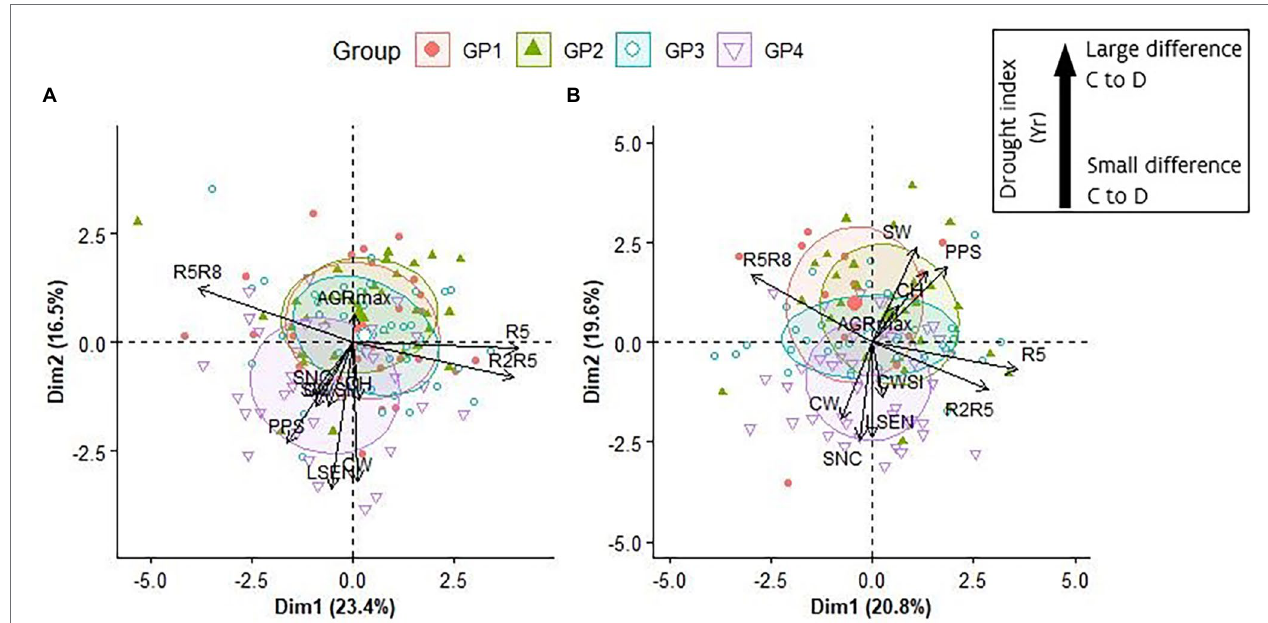
FIGURE 6 | Representation of the first two axes of a Principal Component Analyses (PCA) performed on Yr data of R5, R2R5, R5R8, PPS, SW, AGRmax, CH, SNC and CWSI and BLUP values for LSEN and CW in 2018 (A) and in 2019 (B) . For representation purposes the “Yr” indicator has been removed from the variable names (e.g., in these plots “R5R8” represents “R5R8-Yr”). The inset in the figure does not apply to the interpretation of SNC